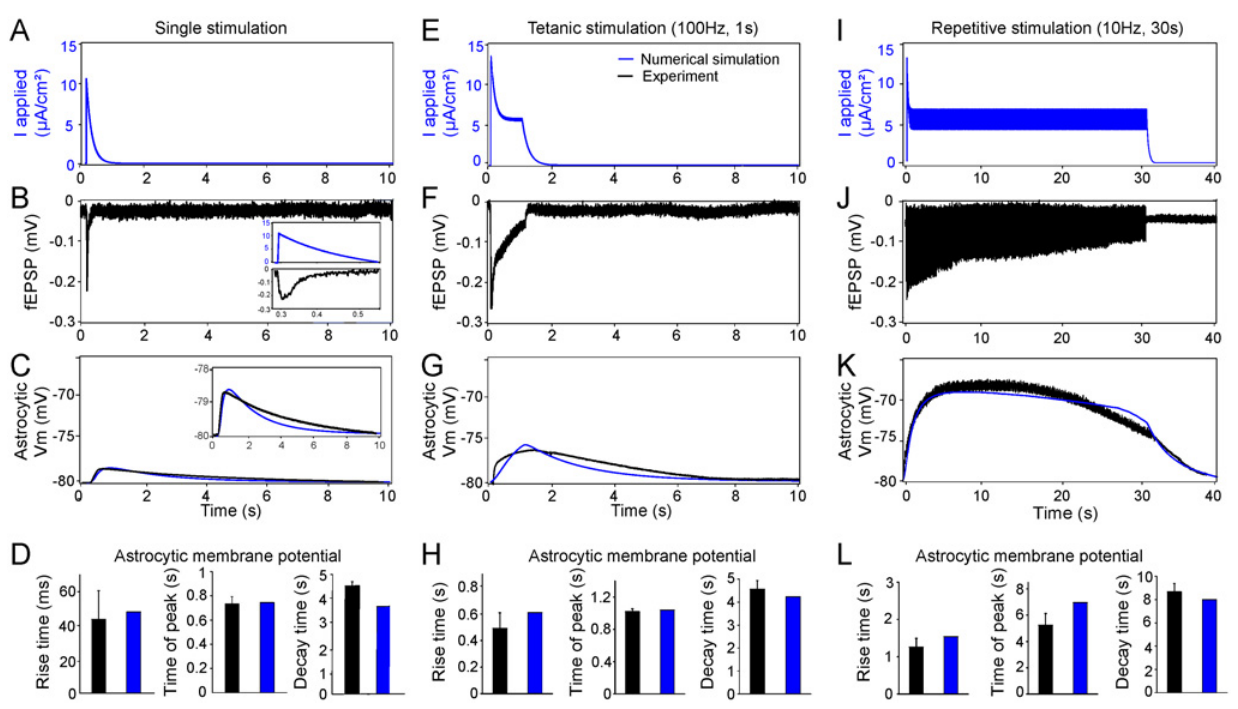
Fig 2. Dynamics of astroglial membrane potential induced by single, tetanic and repetitive stimulations. comparison of simulations and experiments A ), tetanic (100 Hz, 1 s) ( E ) and repetitive (10 Hz, 30 s) ( I ) stimulations A , E , I , Numerical simulation of the applied current (I app , blue) induced by single ( generated by the depression-facilitation model with inputs f(t) = f S (t) (Equation 4), f(t) = f TT (t) (Equation 5) and f(t) = f RS (t) (Equation 6), respectively. B , F , J , Representative electrophysiological recordings of synaptic transmission (field excitatory postsynaptic potential, fEPSP, black) induced by single ( B ), tetanic (100 Hz, 1 s) ( F ) and repetitive (10 Hz, 30 s) ( J ) stimulations of Schaffer collaterals in acute hippocampal slices. Inset in panel B is a magnification of the simulated applied current (I app ) illustrated in ( A ) and the corresponding experimental field excitatory postsynaptic potential (fEPSP) shown in ( B ). C , G , K , Superimposition of astrocytic membrane potential dynamics obtained by electrophysiological recordings (black) and numerical simulations (blue) generated by equation 23 during single ( C ), tetanic ( G ) and repetitive stimulations ( K ). Inset in panel C is a magnification of the simulated and experimentally recorded astrocytic membrane potentials D , H , L , Quantification of astrocytic membrane potential kinetics extracted from experimental data (black) and numerical simulations (blue). The rise and decay times are computed between 20% and 80% of the maximal peak amplitude response.